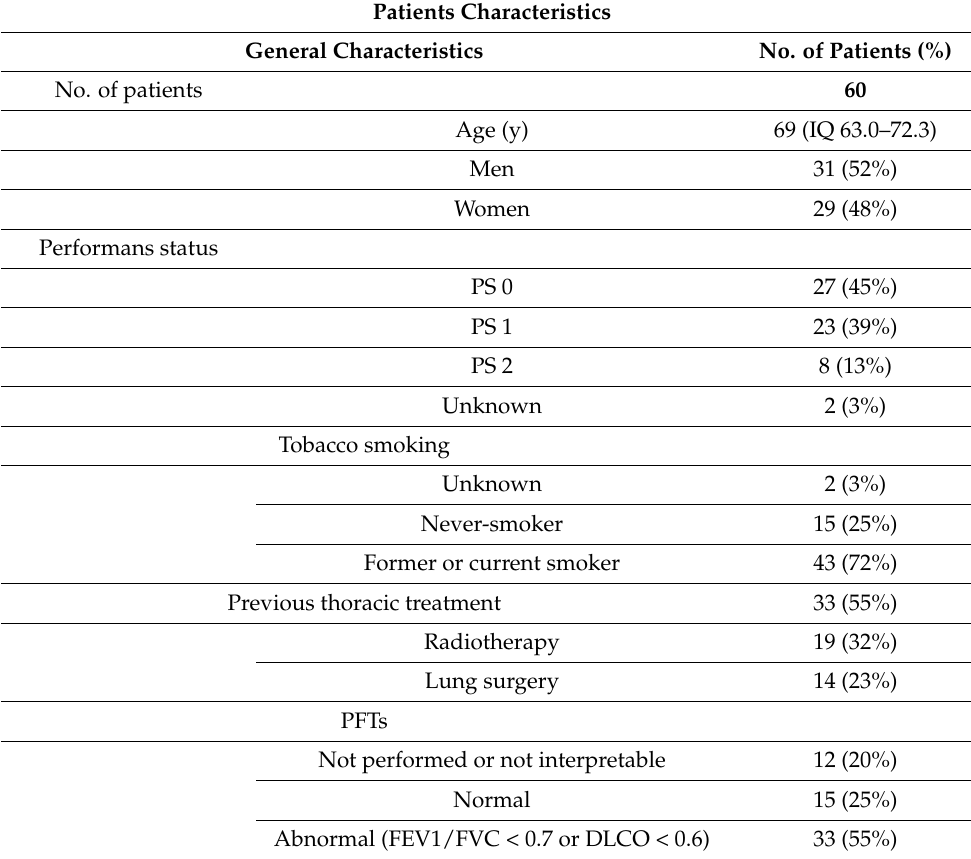
Table 1. Characteristics of the